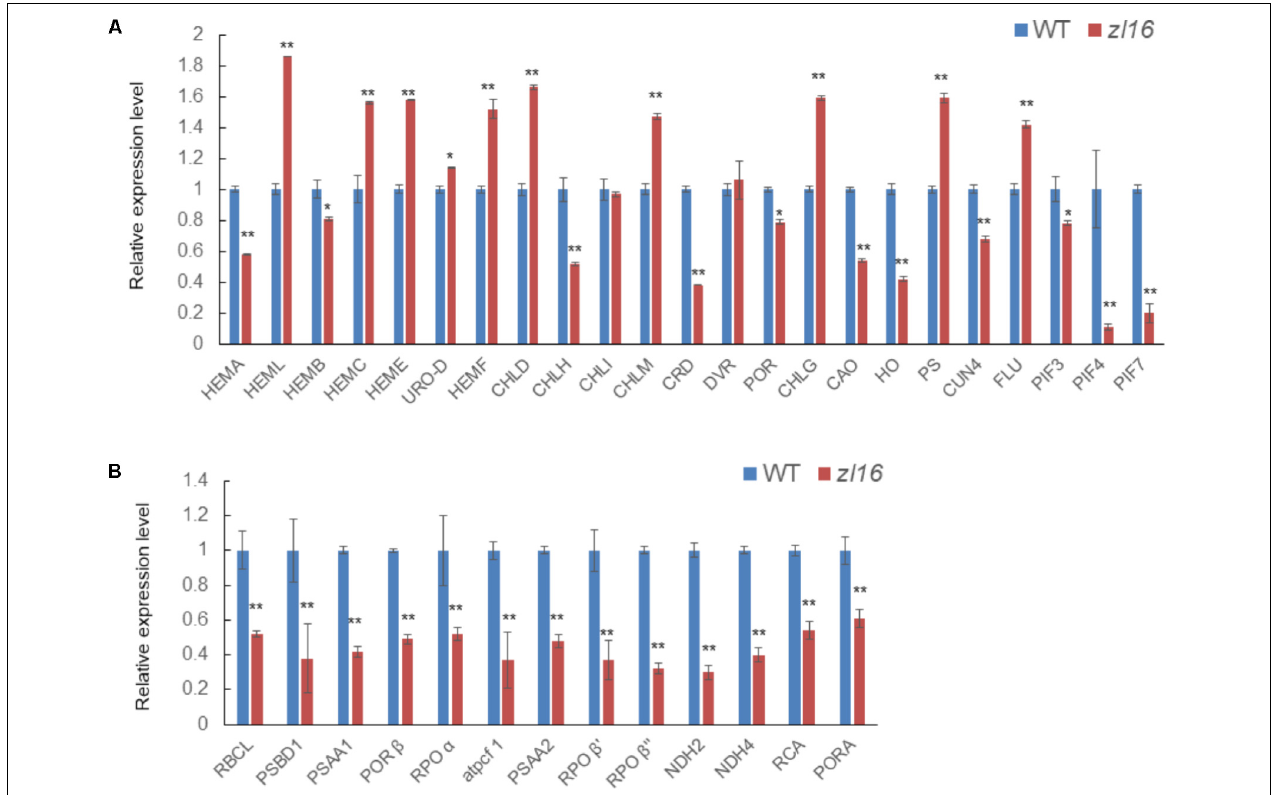
FIGURE 9 | Expression analysis of genes associated with chlorophyll biosynthesis and plastid development in the wild type (WT) and zl16. (A) Relative expression of genes involved in chlorophyll biosynthesis. (B) Relative expression of genes involved in plastid development. Experiments were normalized using the Ubiquitin gene as an internal control. Data are means ± SD of three